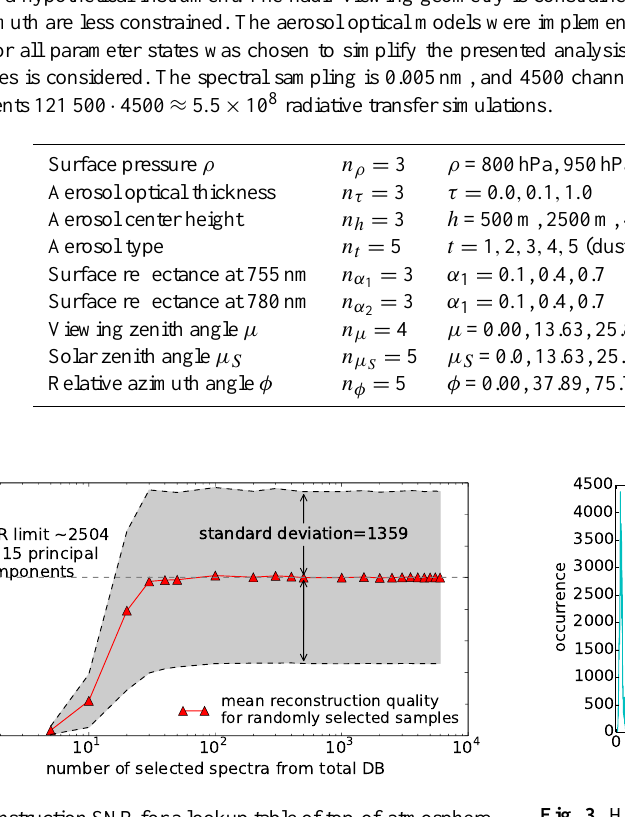
Fig. 2. Reconstruction SNR for a lookup table of top-of-atmosphere radiances in the oxygen A band (see Table 1 and Fig. 5 for reference). The reconstruction SNR was defined as the ratio of the standard deviation of the residual and the mean value of the truth where the residual was defined as the difference between truth and reconstruction. The considered index set was randomly chosen. For each step, computations were repeated 50 times, and the mean value is shown. Shown is the mean reconstruction SNR, which is the mean value over the reconstruction SNR for all cases in the lookup table. The grey shaded area shows the corresponding standard deviation. A histogram for the whole data set is shown in Fig. 3.